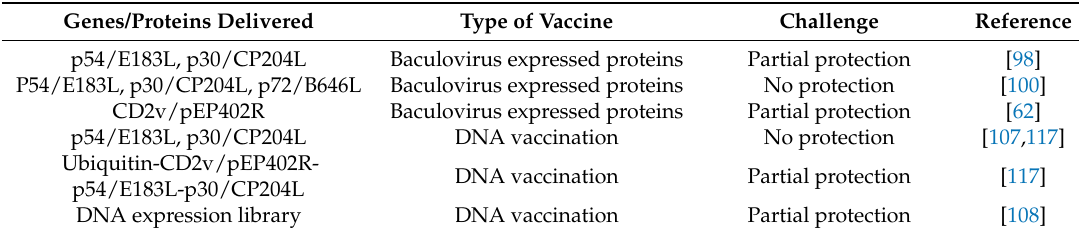
Table 1. Approaches for development of subunit protein or DNA